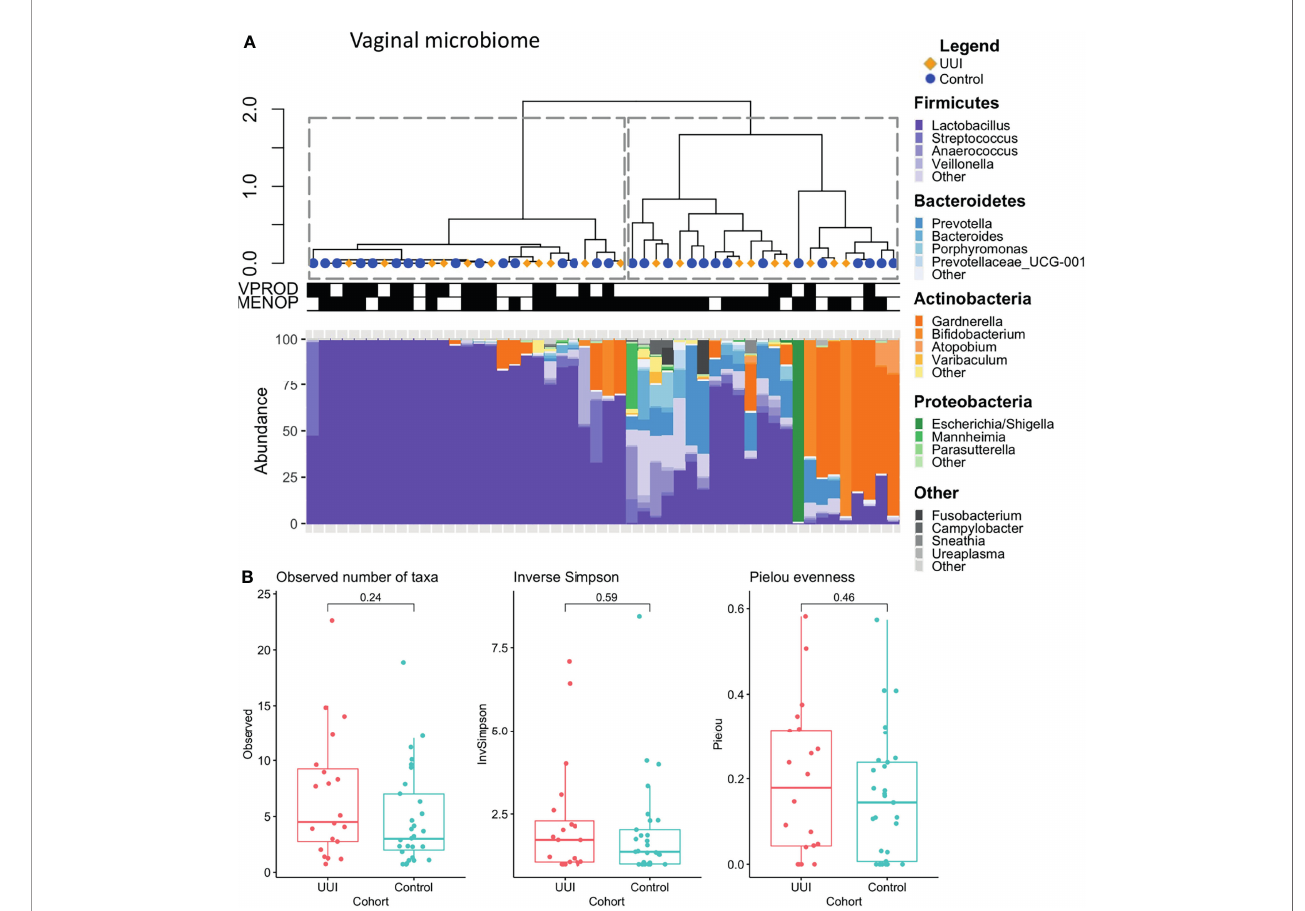
FIGURE 1 | (A) Clustering of vaginal microbiome is associated with use of vaginal products. Hierarchical clustering (top) was performed using the Ward ’ s minimum variance method on weighted UniFrac distances between samples. Stacked bar plots (bottom) show relative abundance of vaginal microbiome of women with and without UUI. Dotted lines outline clusters that were chosen based on the Silhouette metric. Black bars underneath annotate for clinical features being TRUE. Vaginal product use was signi fi cantly associated with vaginal microbiome cluster (p = 0.004), menopausal status was not (p = 1.0, Fisher ’ s exact test). Cases are labeled with yellow diamonds and controls are labeled as blue squares. VPROD, any vaginal product use; MENOP, post-menopausal. (B) Women with and without UUI do not differ in vaginal microbiome diversity. Alpha diversity is visualized using box-and-whisker plots and measured using observed number of taxa (genera, p = 0.24), inverse Simpson Index (p = 0.59), and Pielou evenness index (p= 0.46). A generalized linear model was used to adjust for age, BMI, and menopause-estrogen